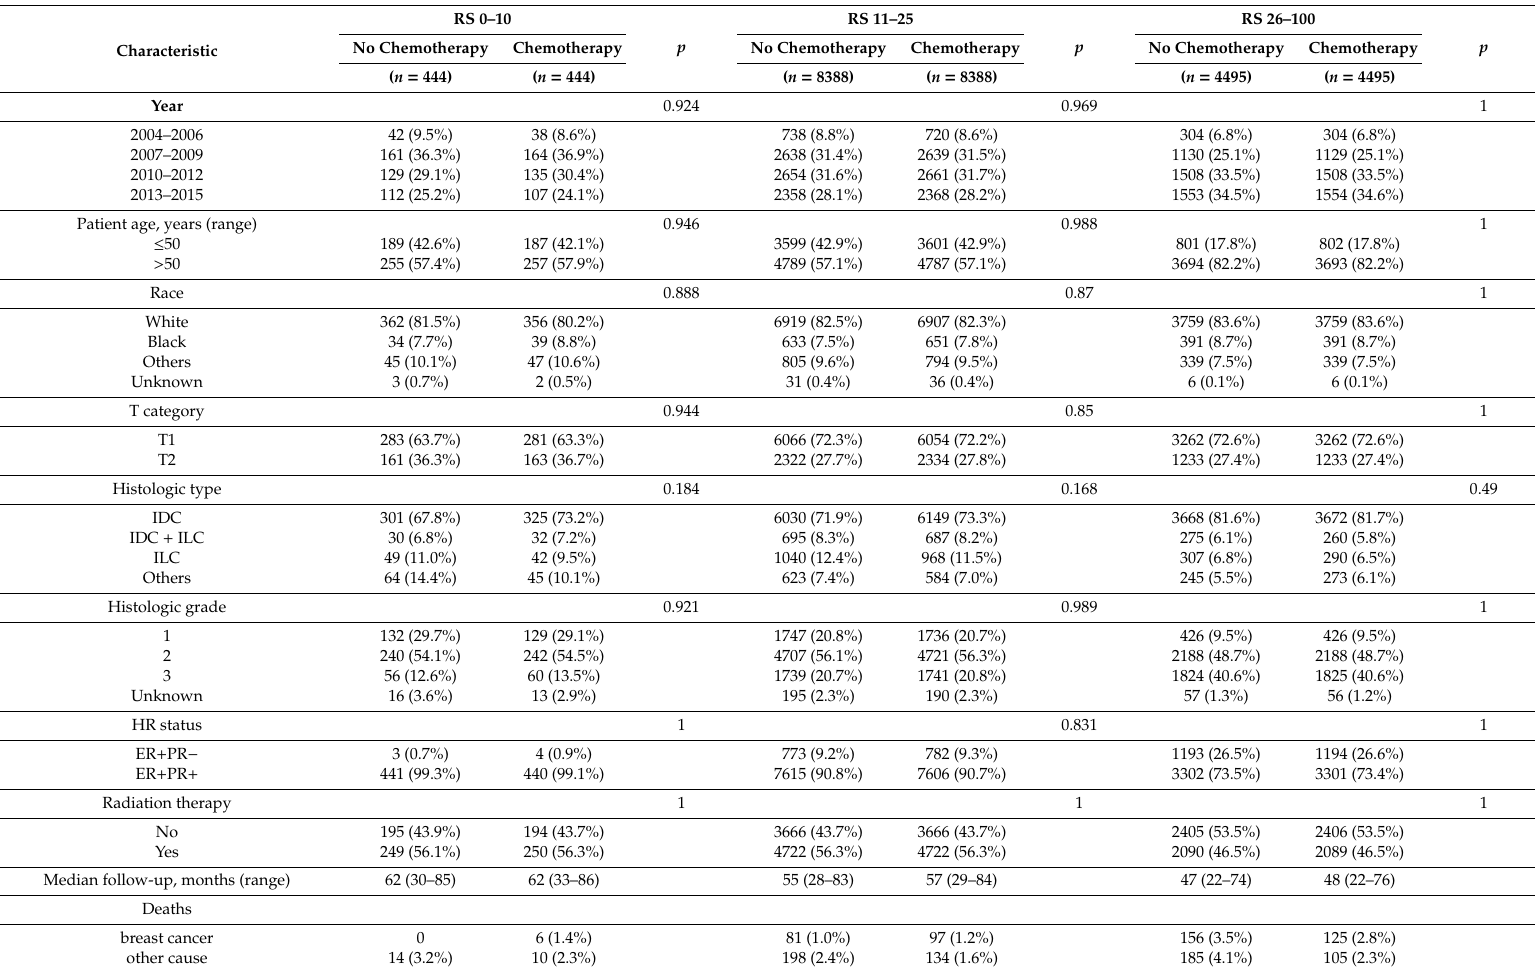
Table 1. Baseline characteristics according to chemotherapy in the matched